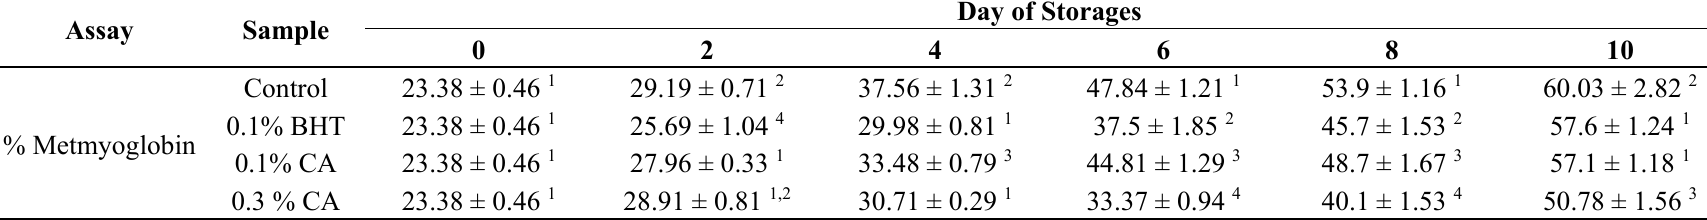
Table 3. Effects of CA extract and BHT on metmyoglobin changes in beef patties during 10 days of refrigerated storage at 4 °C. (Mean ± SE). Assay